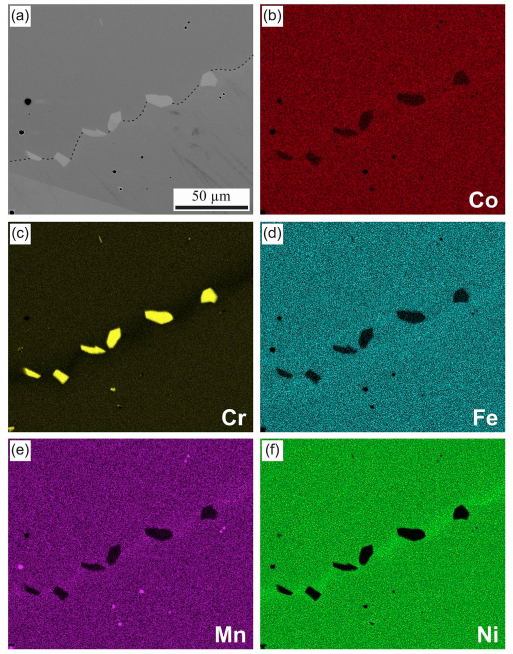
Figure 1. Microstructure of the CrMnFeCoNi HEA after a 500-day anneal at 700 ◦ C. ( a ) Representative BSE image showing the presence of blocky faceted precipitates on a grain boundary. ( b – f ) Elemental energy dispersive X-ray (EDX) maps showing significant enrichment of Cr in the precipitates (relative to its concentration in the HEA) and depletion of all other elements. The dashed line delineating the GB in ( a ) was added as a guide for the eye. There appears to be a slight enrichment of Mn and Ni near the GB in ( e , f ). Reprinted with permission from Ref. [5]. Copyright 2016 Elsevier.